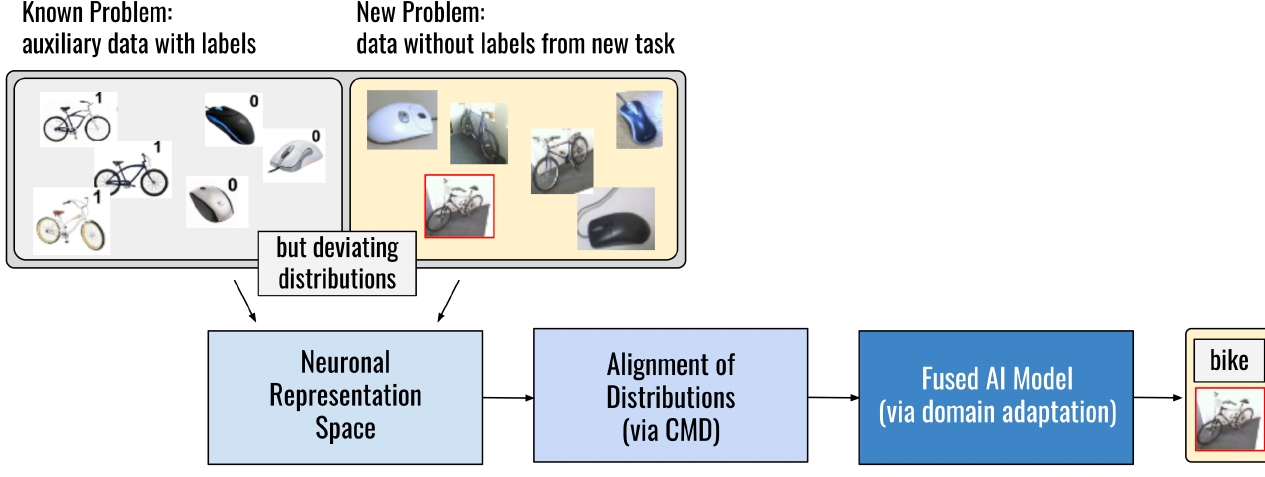
Figure 4. Illustration of domain adaptation: adapt learning capabilities from an auxiliary known problem with known labels to a new task with deviating distribution and unknown labels